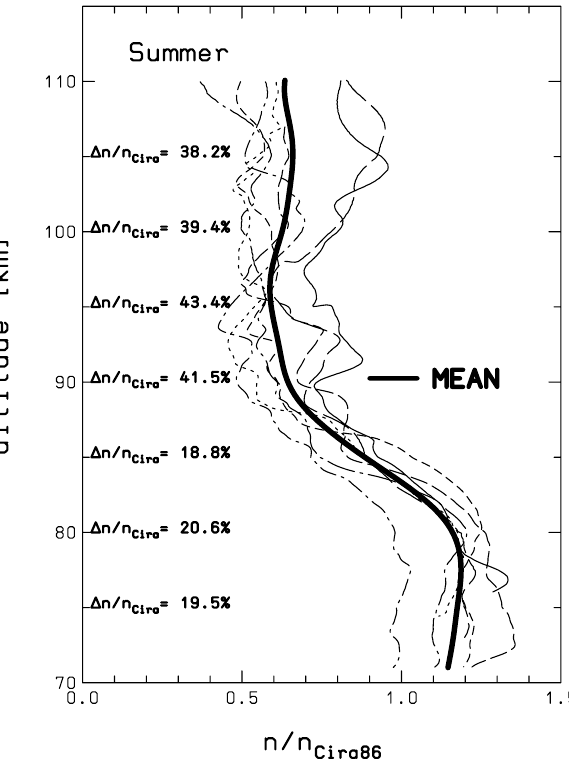
Fig. 8. All summer density profiles measured with the TOTAL or CONE ionization gauges divided by the appropriate CIRA86 ref- erence profile. The thick line indicates the mean profile of all ion- ization gauge measurements. Furthermore, the deviation between the mean ionization gauge densities and CIRA86 is indicated every 5